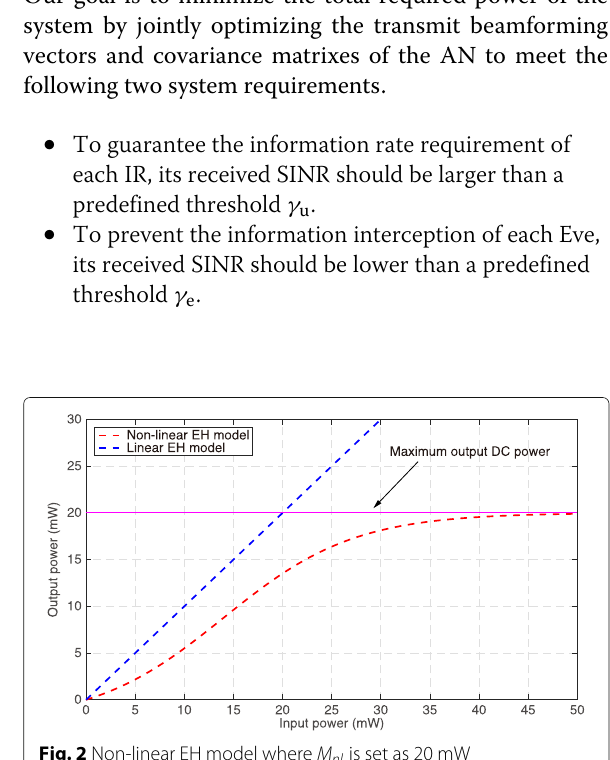
Fig. 2 Non-linear EH model where M nl is set as 20